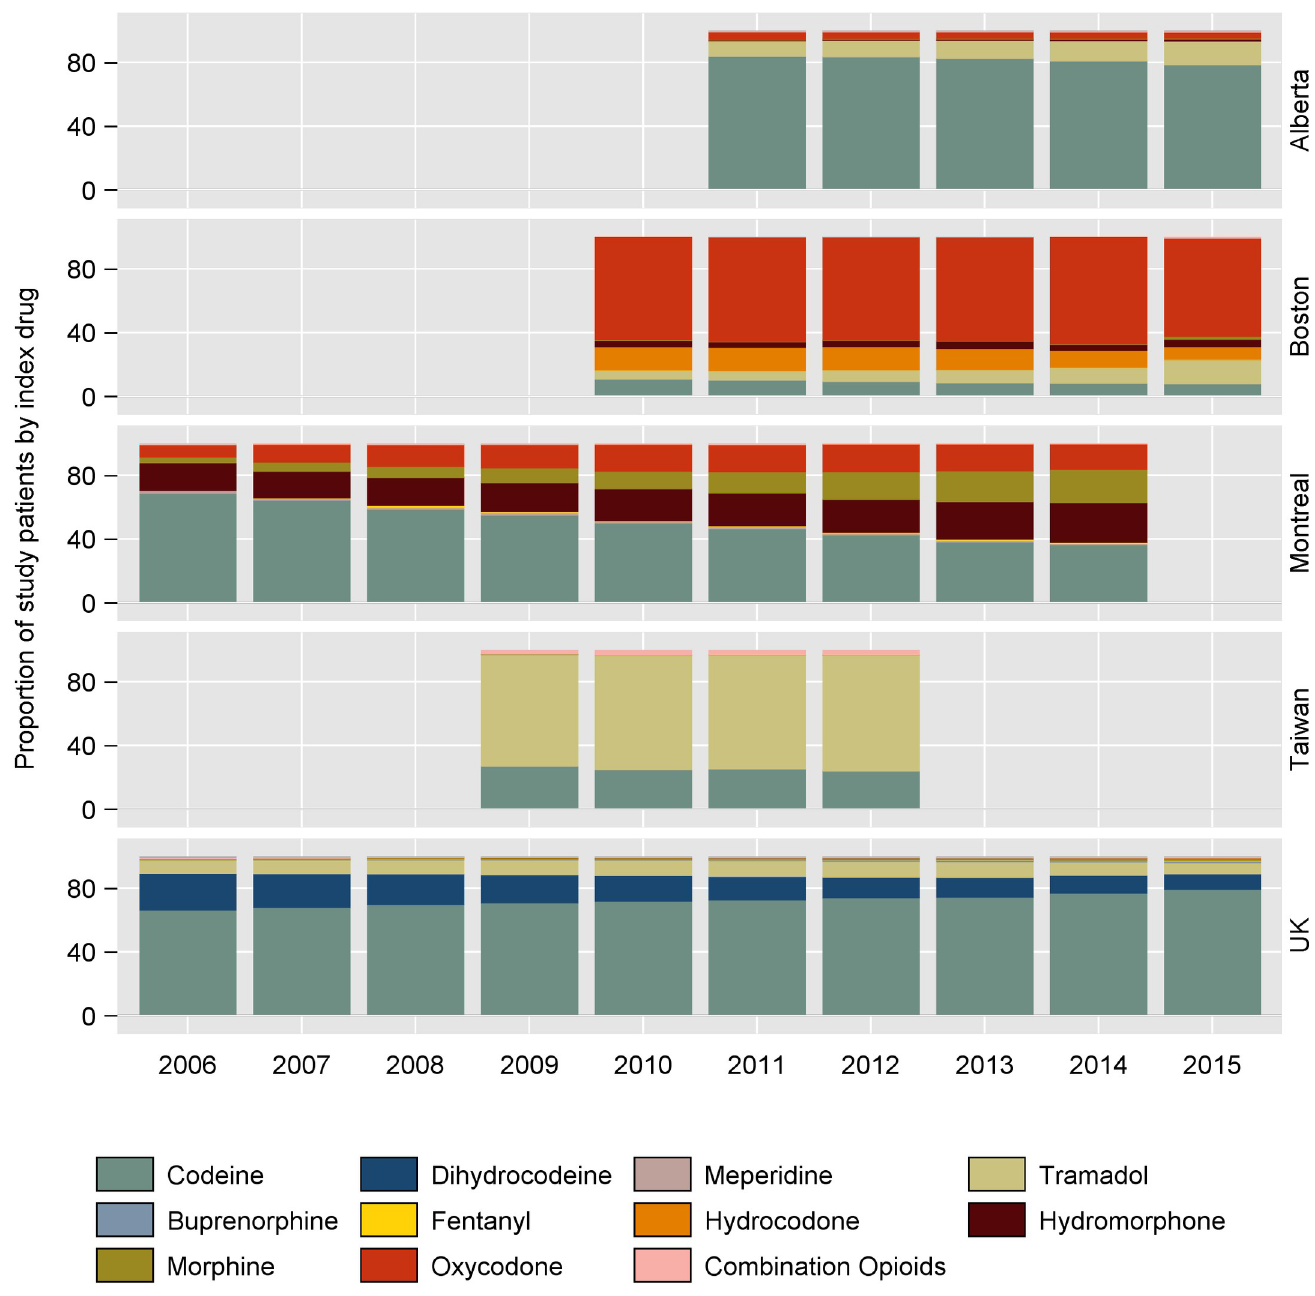
Fig 4. Opioid trends over time by